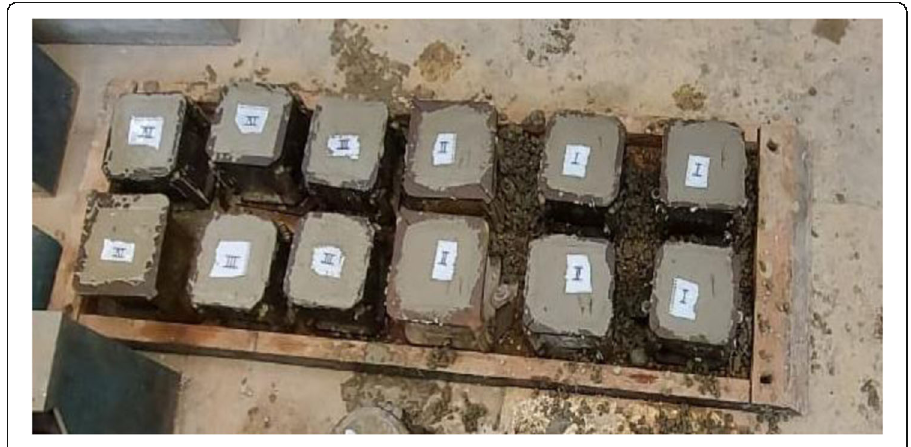
Fig. 1 Concrete cubes (150 × 150 × 150 mm)